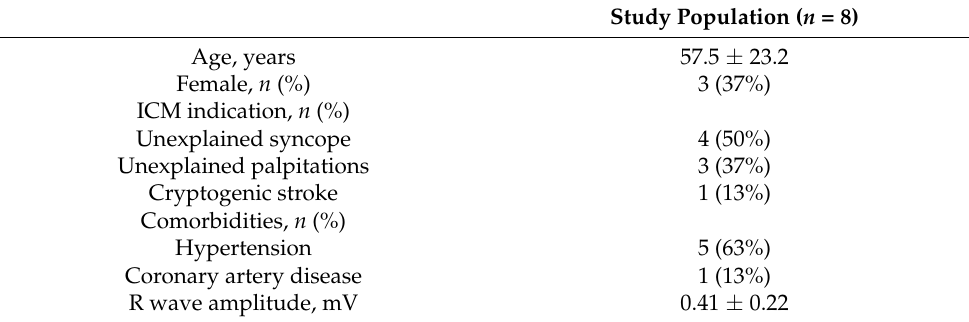
Table 2. Patient